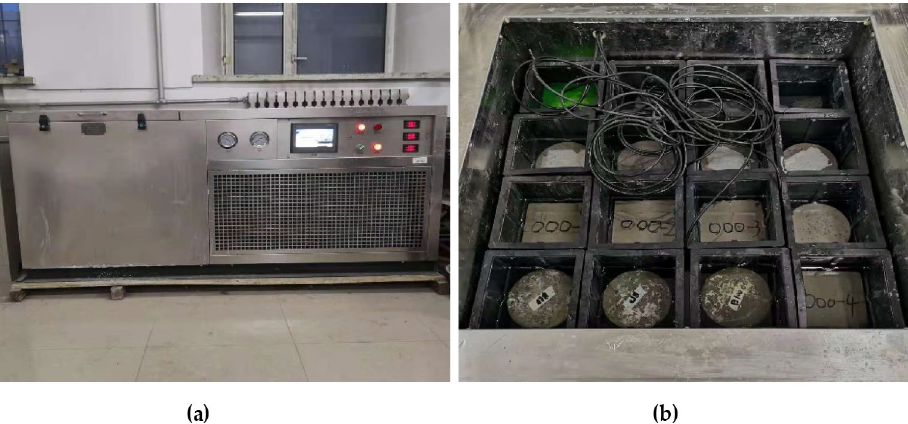
Figure 3. Freeze thaw circulation box: ( a ) Freeze–thaw cycle box exterior; ( b ) Inside of freeze–thaw circulation box.